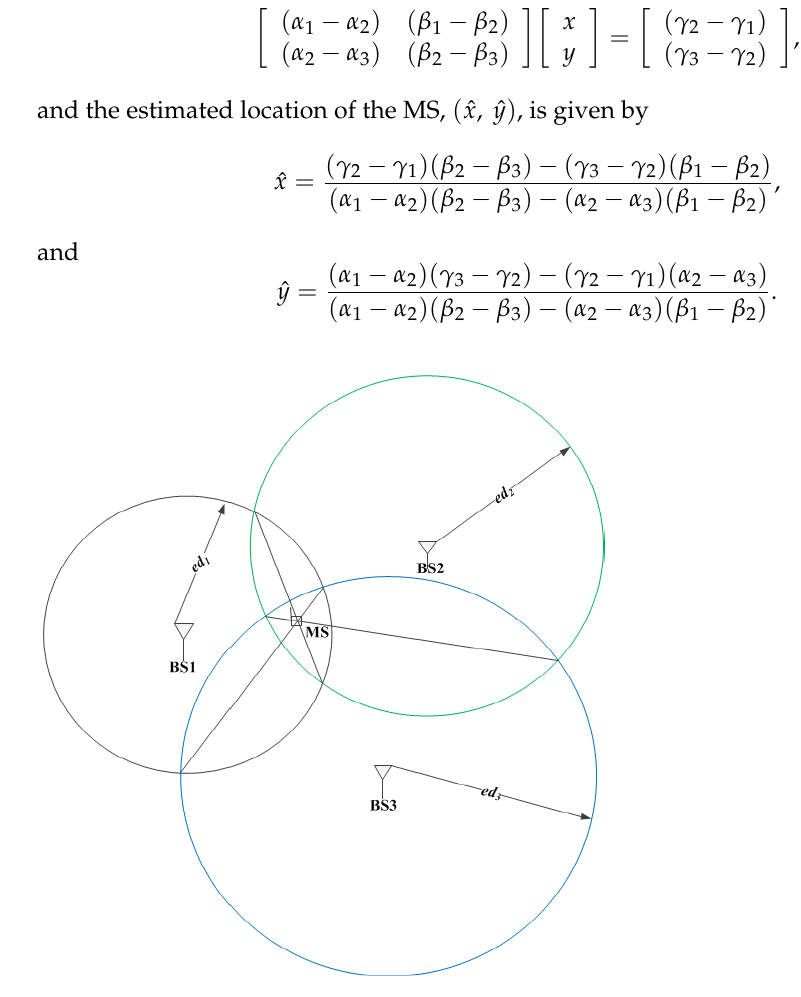
Figure 5. Line intersection algorithm.